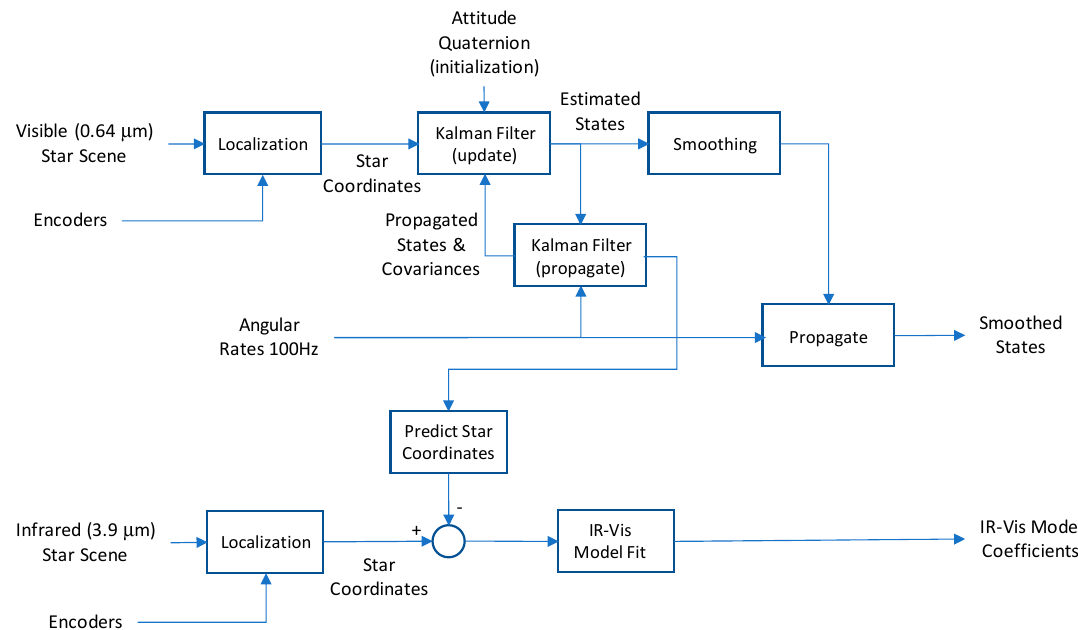
Figure 12. INR processing is implemented on the ground and relies on star scans, attitude rates, scan mirror angular encoder readouts, and an orbit determined from onboard GPS. A Kalman Filter with delayed state update smoothing navigates the VNIR channels, and a separate sliding window batch estimator fits the alignment between the VNIR and IR channels.